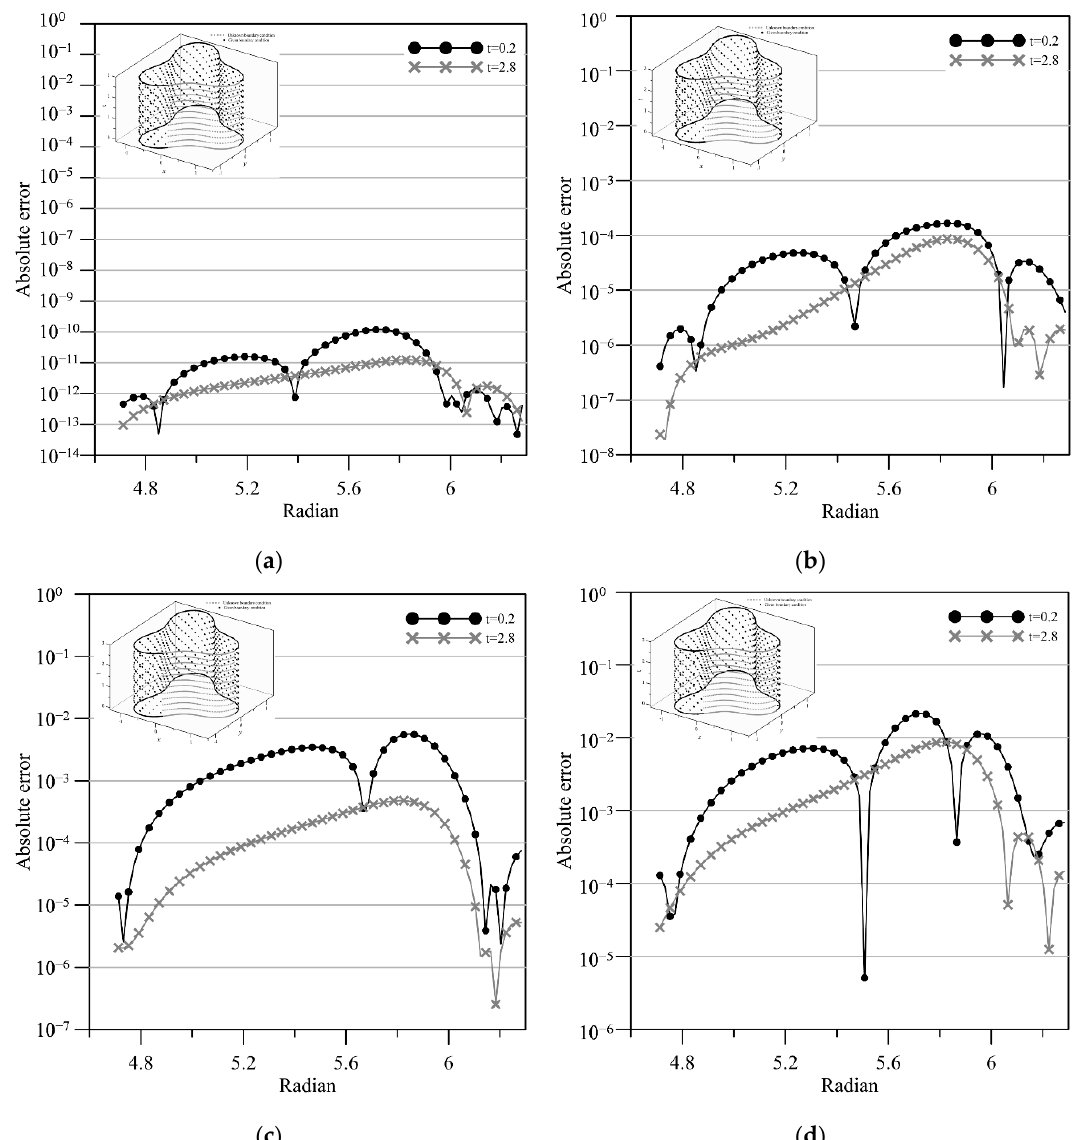
Figure 5. The absolute error: ( a ) s = 0; ( b ) s = 0.001; ( c ) s = 0.01; ( d ) s = 0.1.